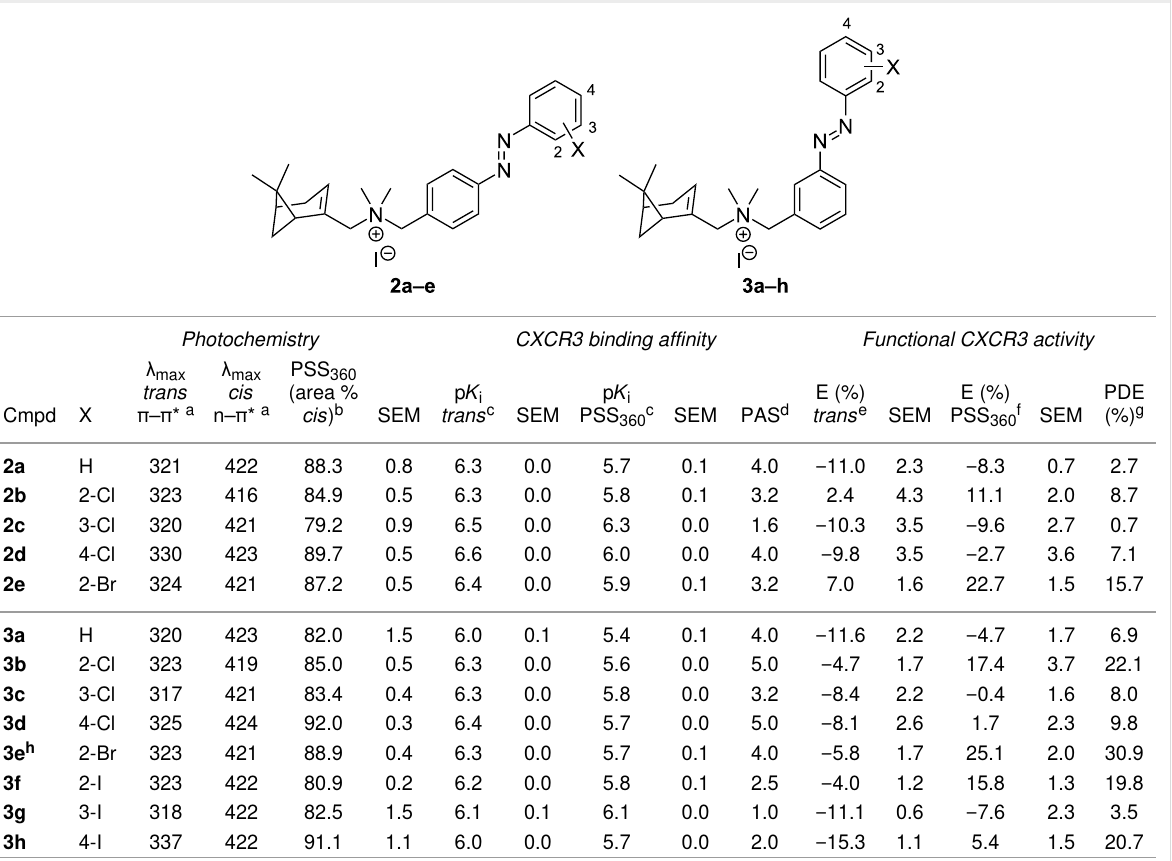
Table 1: Structures and results of photochemical, binding and functional characterization of compounds 2a–e and 3a–h .